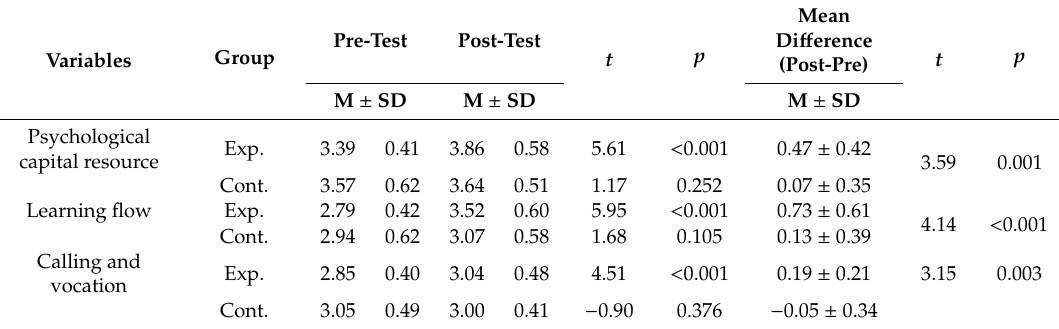
Table 4. Comparisons of outcome variables between the experimental and control